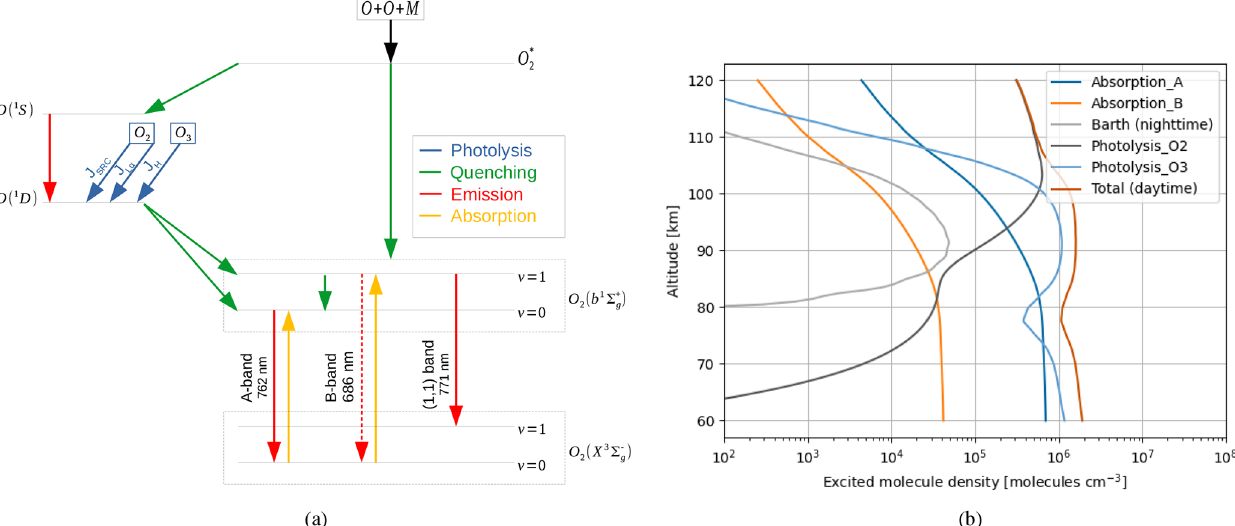
Figure 4. (a) Schematic of the production of excited-state O 2 (b 1 (cid:54) + g ,v = 0 ) ; dashed lines indicate neglected transitions. (b) Number density of excited O 2 molecules due to the different production mechanisms using HAMMONIA model data (Schmidt et al., 2006); note that during daytime all five production mechanisms are active, whereas during nighttime only the Barth process is active.